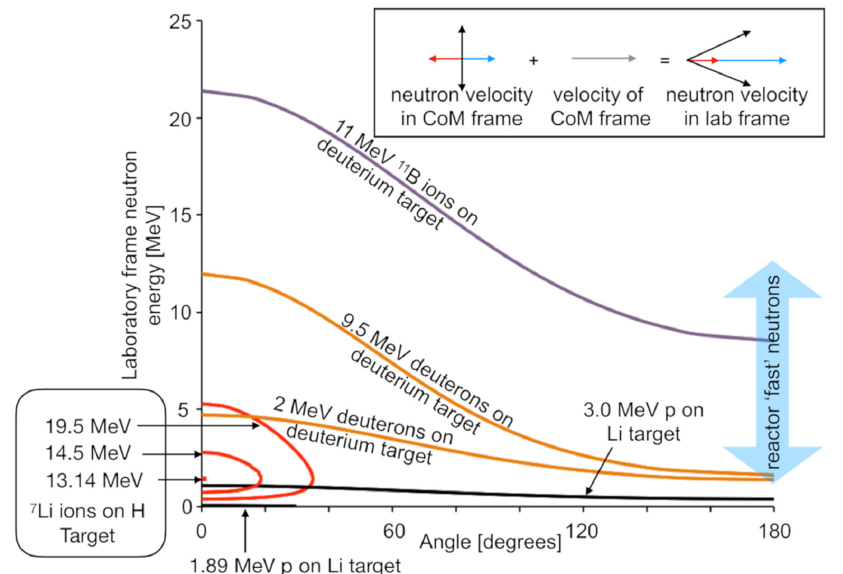
Figure 14. Simulations of examples of the kinematics available for neutron production in thin targets using the accelerators available at DCF. Each line is labelled with the collision conditions pertaining to the neutron production. The x-axis shows the angle at which neutrons would be ejected with respect to the beam axis. The corresponding neutron energy is indicated on the y-axis. Towards the bottom left of this figure, several of the lines, corresponding to the inverse kinematic 7 Li(p,n) 7 Be reaction, are shown. These lines show two values of neutron energy, although they do not cover the full angular range. This is because the reaction can produce two neutron energies in the lab frame, but it is impossible to produce neutrons at large angle, i.e., these collisions result in a directed beam. The insert illustrates the kinematics giving rise to this effect and is explained in the main text.